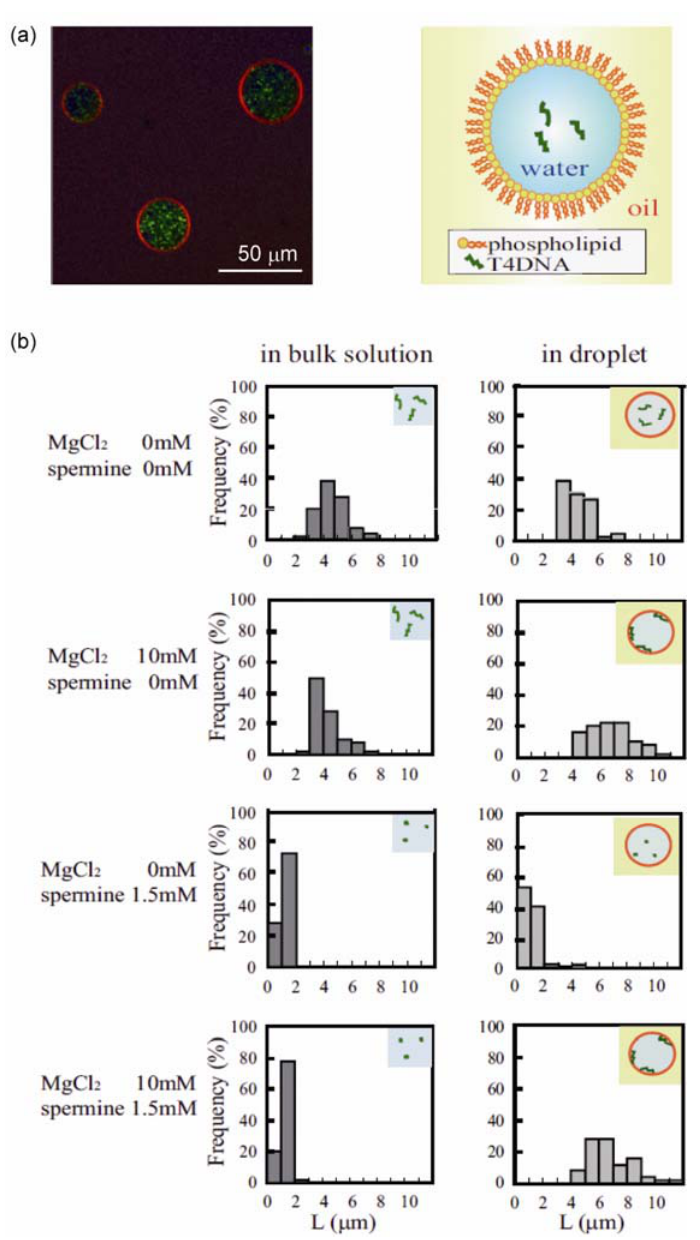
Figure 2. ( a ) Microscopic image of cell-sized droplets encapsulating T4 DNA, together with schematics (right); ( b ) Histogram of the long-axis length ( L ) of T4 DNA molecules under various conditions. Reprinted from [13]. Copyright 2009 with permission from